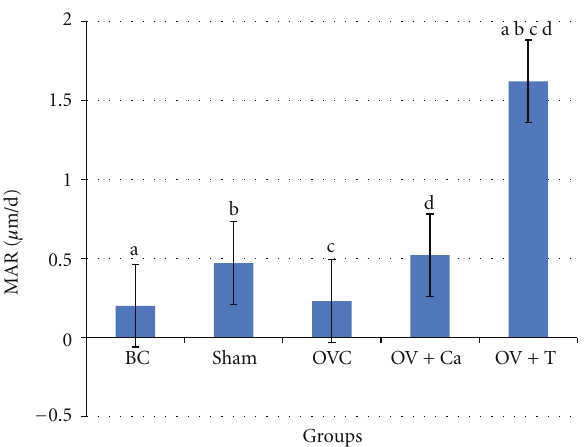
Figure 2: Double-labeled surface (dLS/BS). BC: baseline control group. Sham: sham-operated rats given deionised water and vehicle olive oil. OVC: ovariectomised rats given deionised water and vehicle olive oil. Ov+Ca: ovariectomised rats given 1% calcium in deionised water and vehicle olive oil. Ov+T: ovariectomised rats given deionised water and palm tocotrienol. Same alphabet indicates significant di ff erence between the groups ( P < 0 . 05).